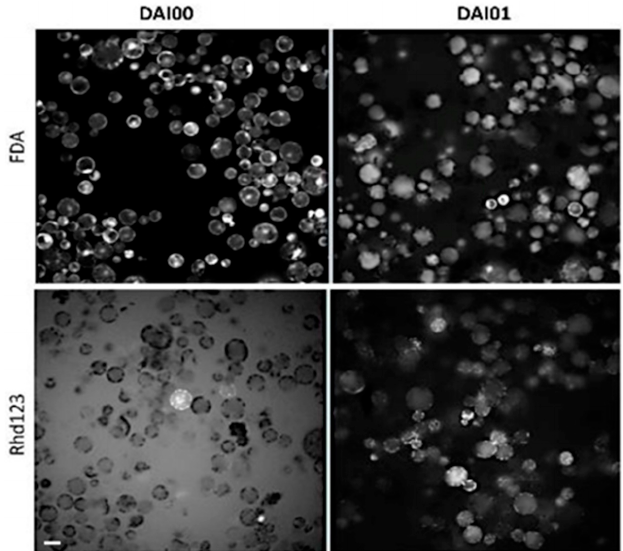
Figure 1. Protoplasts staining with FDA and rhd123. Plasma membrane stability and cell activity detected with fluorescein diacetate (FDA) and Rhodamine 123 (rhd123), respectively. 1 µM FDA and 1 µM rhd123 were added to the protoplast suspension at 1 h after isolation. Images were captured at 3 and 24 h after isolation. DAI- Day after isolation. The rhd123 image has a high background on DAI 0 because the dye was not taken up by the cells and remained in the medium. Scale bar—20 µ